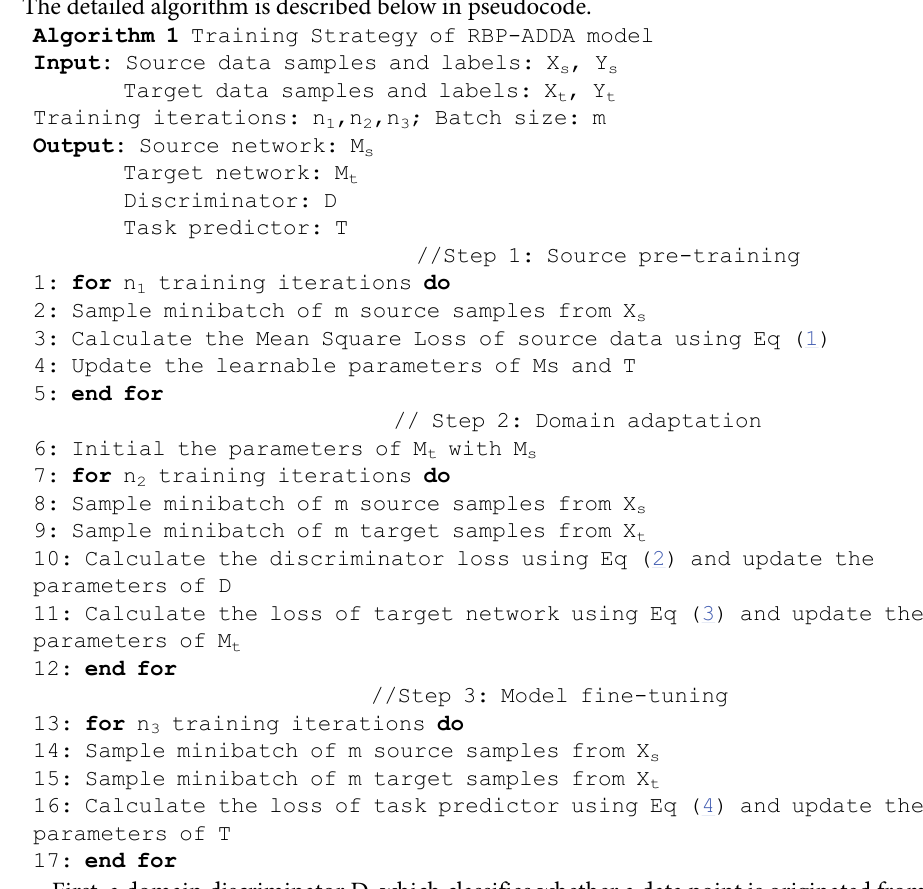
Algorithm 1 Training Strategy of RBP-ADDA